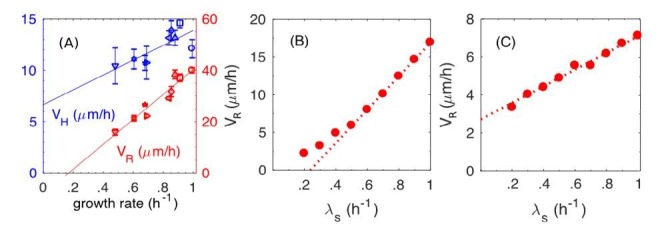
The dynamic and static friction models distinguished by the growth-rate dependence of radial expansion speed.(A) From main text Figure 1F. Experimental results on the radial speed VR and the vertical speed VH with respect to various batch culture growth rates. (B) From Figure 8F in the main text (new version). Simulation results of radial speed VR of the colony, where both static and dynamic frictions are included in simulations. (C) New simulation results of radial speed VR of the colony, where only the static friction is included.